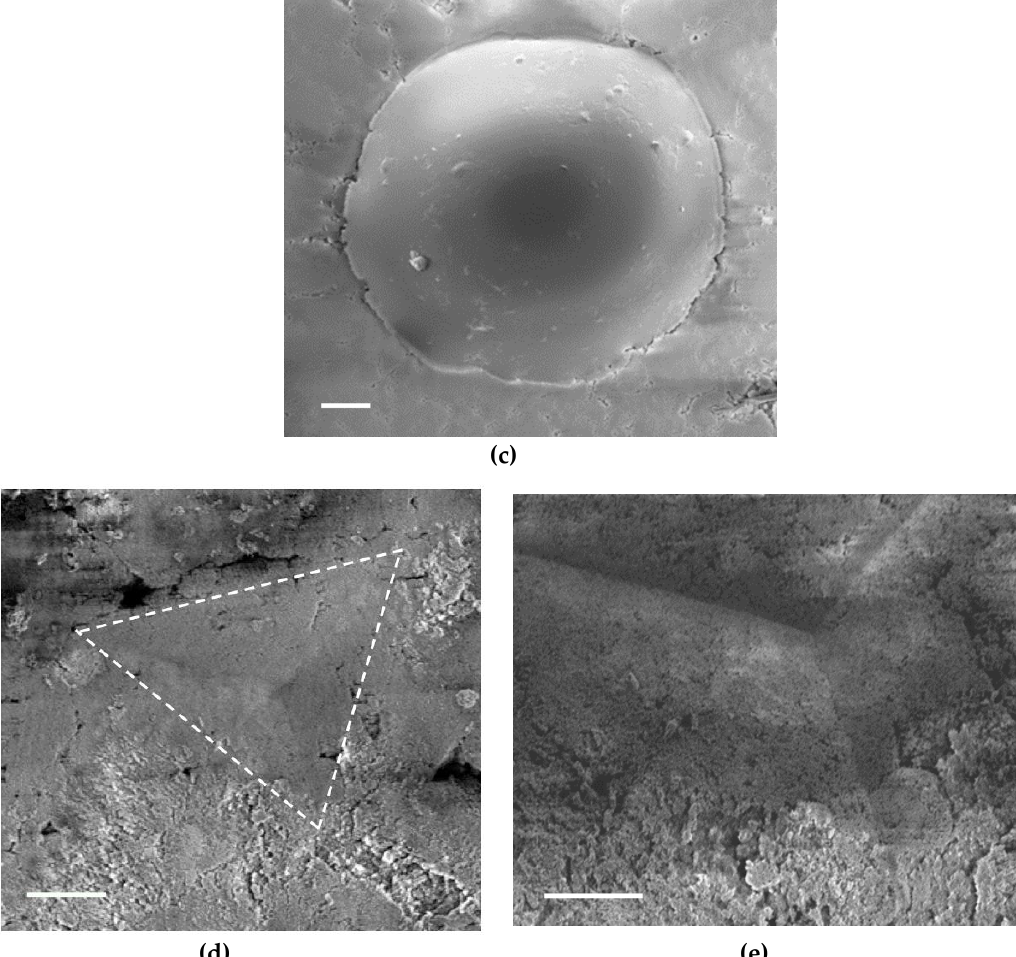
Figure 4. Images of residual indents: ( a ) D600 sphere on an FS compact, load 6 mN, ( b ) D600 sphere on a PS compact, load 6 mN, ( c ) D2000 sphere on an FS compact, load 50 mN, ( d , e ) Berkovich on an FS compact, load 1 mN (dotted lines in d added as guidelines). Scale bar: (a) 20 µm, (b) 20 µm, (c) 20 µm, (d) 20 µm, and (e) 10 µm.